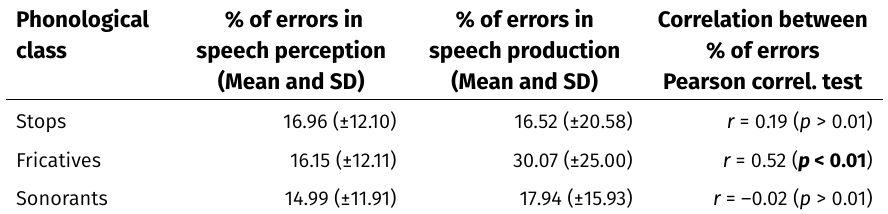
Table 2: Statistical analysis of the errors in speech production and speech